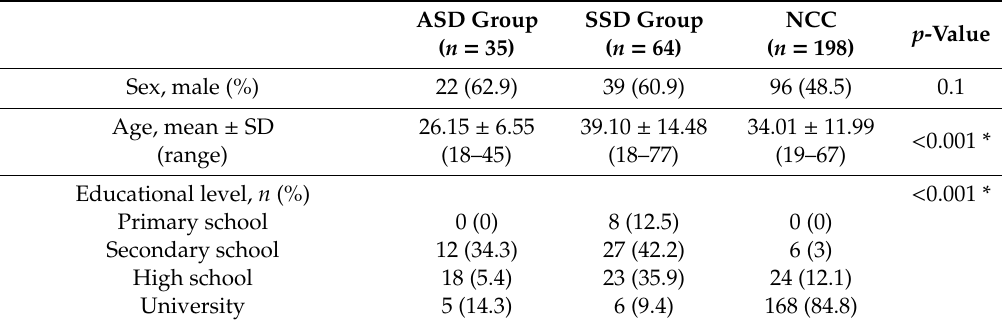
Table 1. Characteristics of